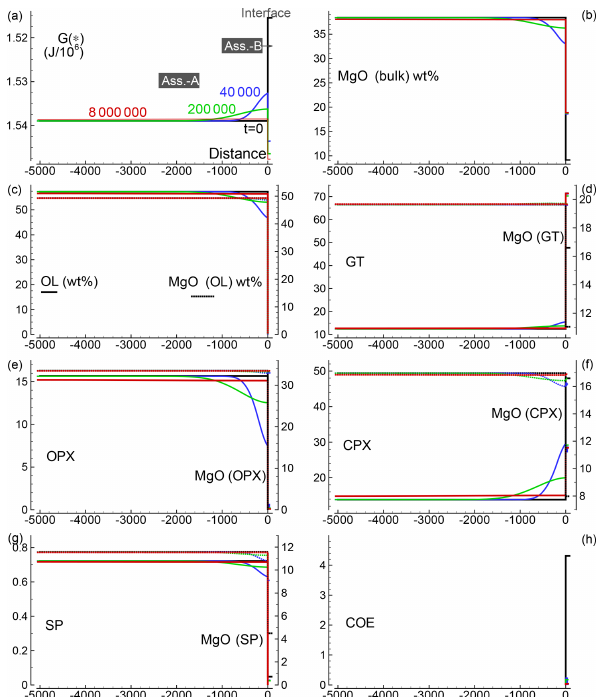
Figure 4. Solution for a 1-D model. The initial proportion of the two assemblages is 50 : 1 ( f = 50). The description of the panels follows the caption provided for Fig. 2. The raw data file for all nine oxides can be retrieved online, but no animation file is available for this